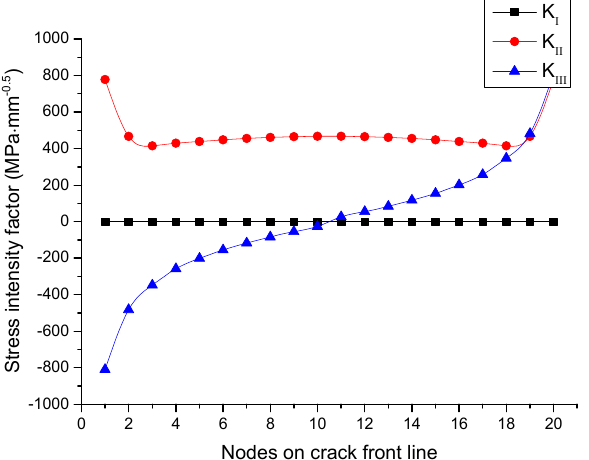
Figure 18. Distribution of Stress Intensity Factor on the crack tip line under mode II loading.